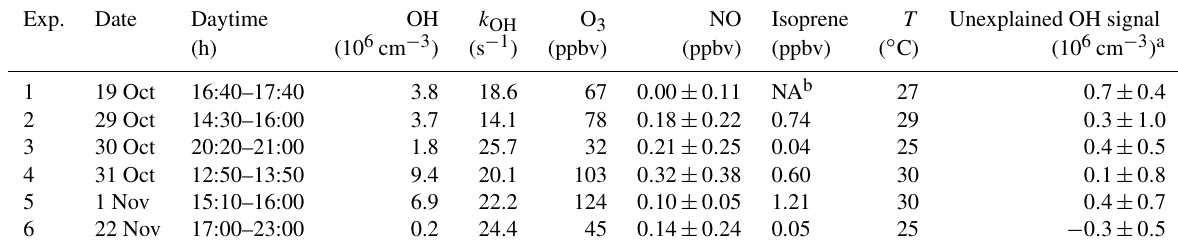
Table 3. Unexplained OH signal (mean ± 1 σ ) and chemical conditions during the OH chemical modulation test experiments. Given numbers are average values of multiple tests that were performed in the specified time period (see, for example, Fig. S3).